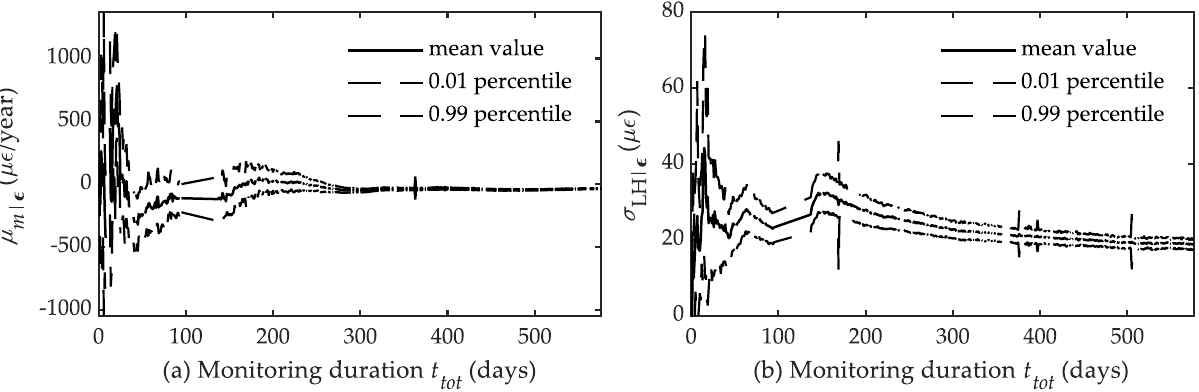
Figure 9. ( a ) Mean value and percentiles 0.01 and 0.99 of parameter m a posteriori; ( b ) mean value and percentiles 0.01 and 0.99 of the likelihood-function uncertainty σ LH | ε a posteriori.